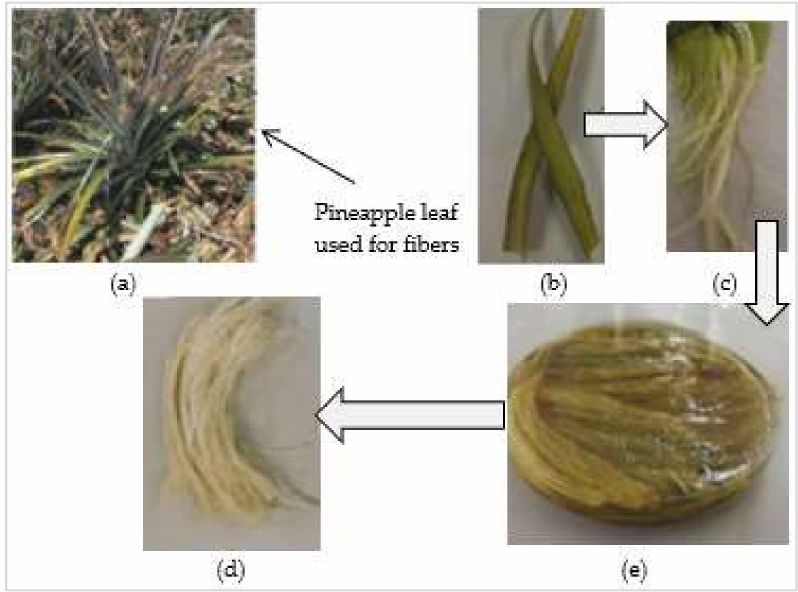
Figure 13. Pineapple fiber: ( a ) plant, ( b ) leaves, ( c ) raw fiber, ( d ) 1% NaOH treatment solution, and ( e ) treated fibers